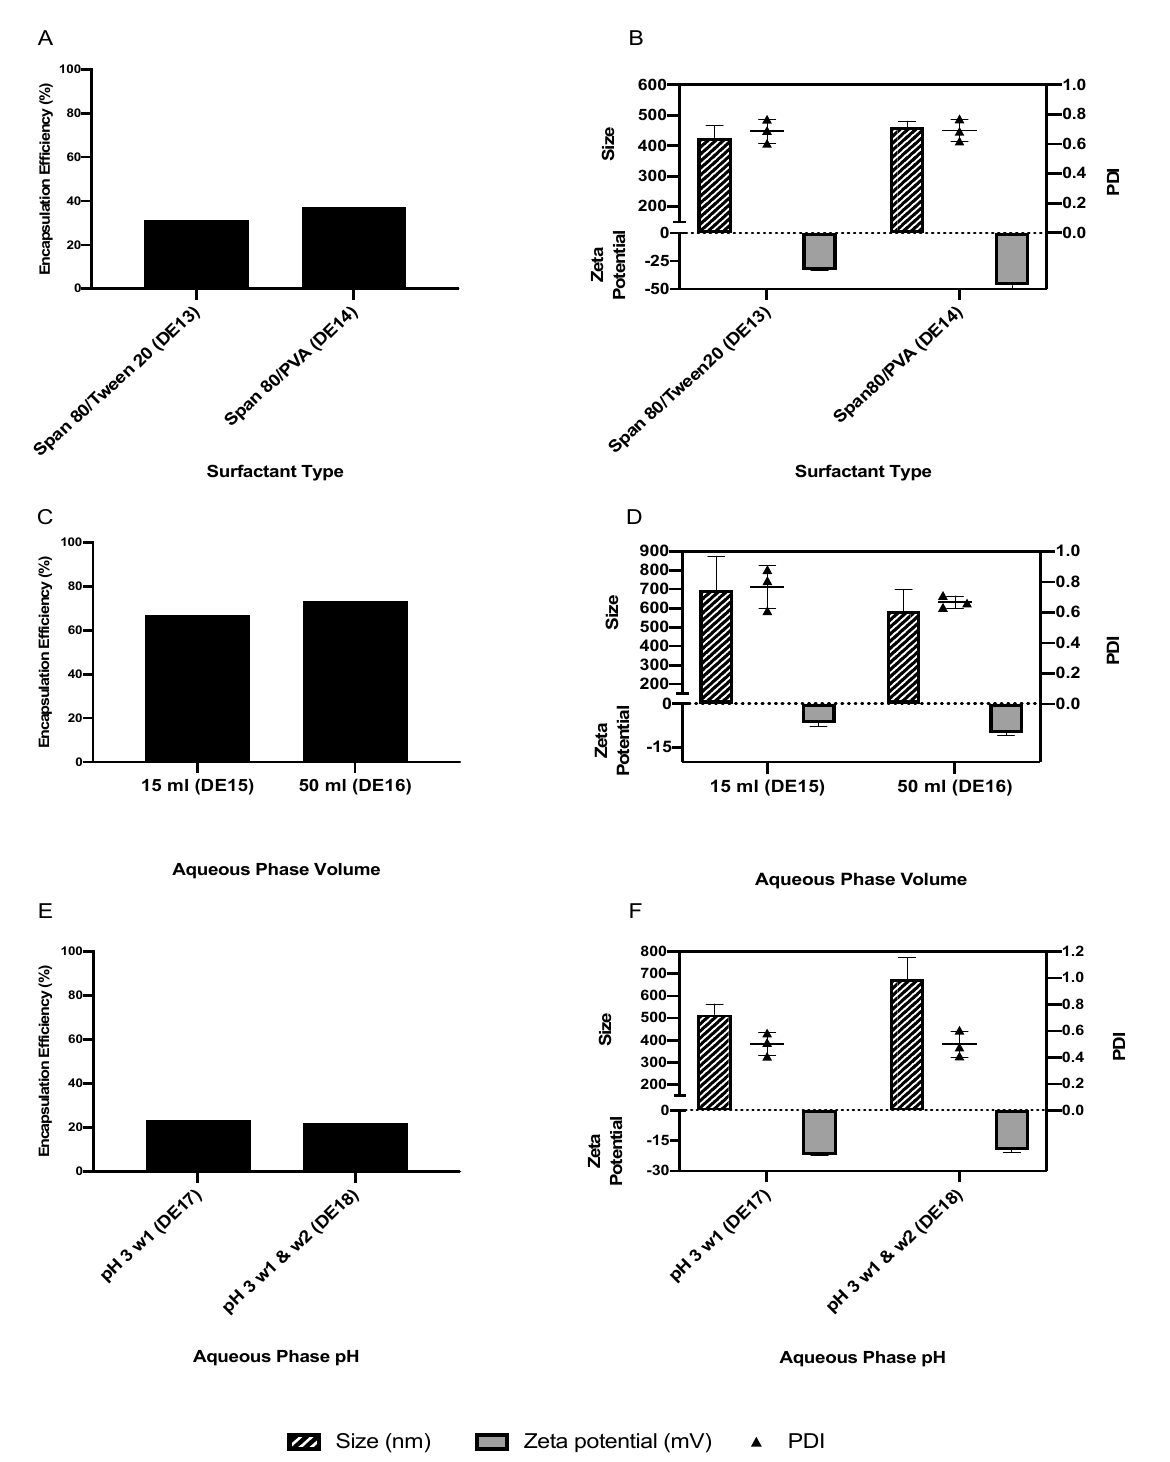
Figure 5. The impact of surfactant type ( A , B ), aqueous phase volume ( C , D ) and aqueous phase pH ( E , F ) on the average particle size, PDI, zeta potential and EE of optimized nanoparticles manufactured using the double emulsion technique. Attempts to improve the EE started with the inclusion of a matrix material (Na alginate) to provide more matrix to entrap the drug. This approach (DE3) provided an EE of 18.7% (Figure 3A), which was considered too low, while increasing the particle size (Figure 3B). Based on the positive EE data for the amorphous PCL using the single emulsion technique, it was investigated using the double emulsion technique. The use of amorphous PCL